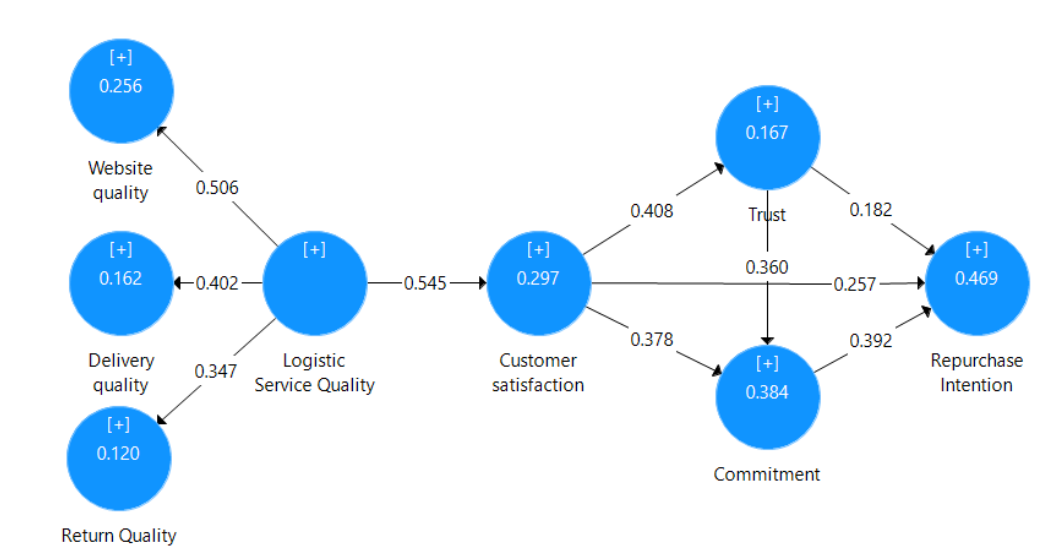
Figure 2: Research Model Path